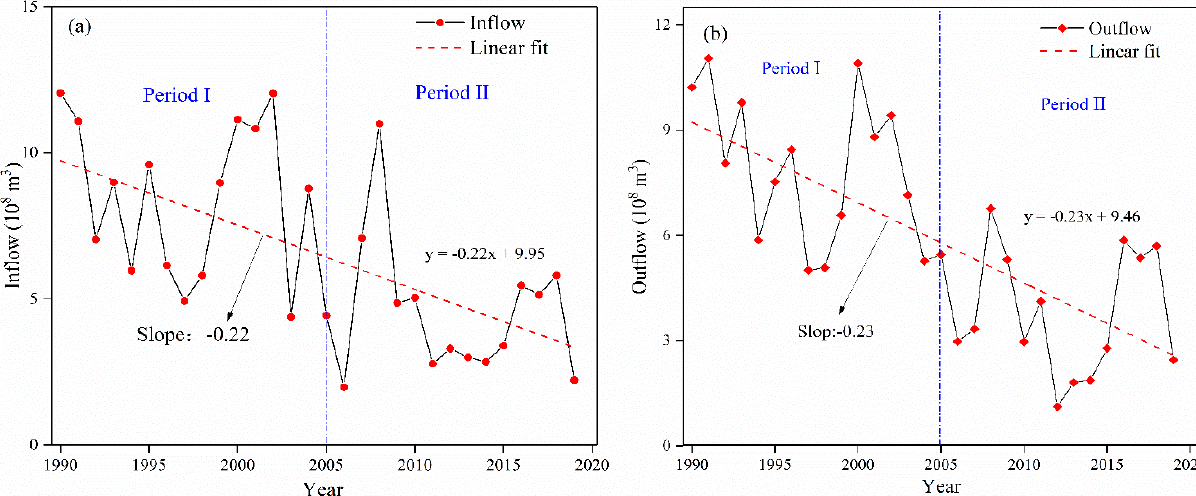
Figure 4. Interannual changes in the inflow and outflow of Erhai Lake. ( a ) and ( b ) are the inflow and outflow of Erhai Lake during 1990–2019, respectively. Note that outflow includes the Xi’er River outflow and the diversion of water from Erhai Lake into Binchuan County.